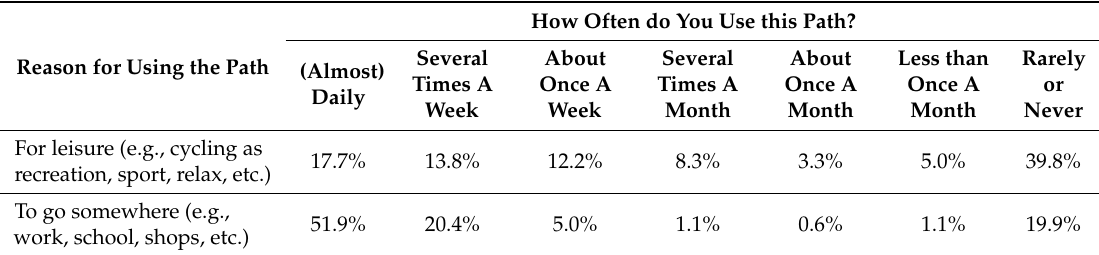
Table 2. Frequency and type of use of the path by the 181 interviewees.